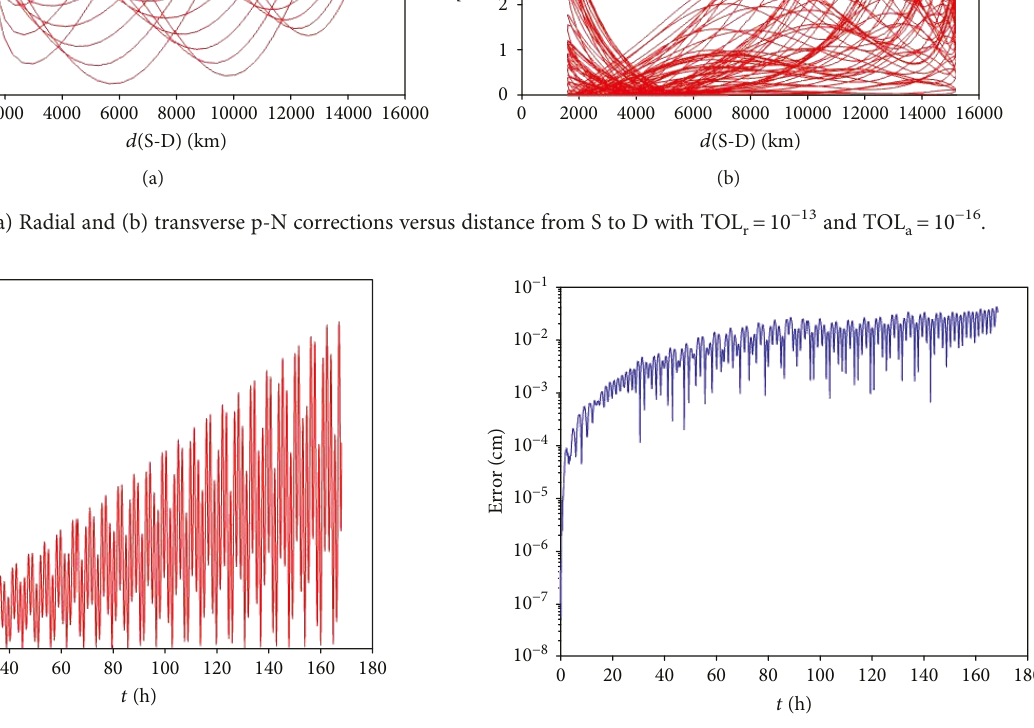
=10 − 13 and TOL =10 − 16 r a